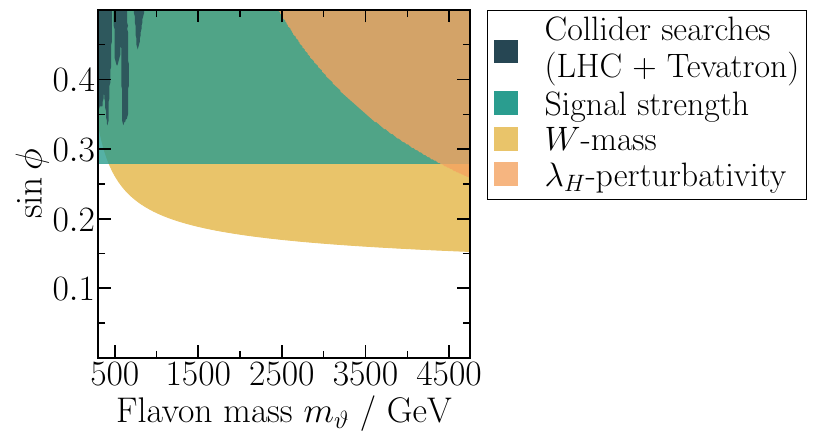
Figure 2. 95% CL limits on the Higgs-flavon mixing angle stemming from direct Higgs searches at the LHC and Tevatron (obtained using HiggsBounds ), ATLAS signal strength measurements, the W boson mass and perturbativity of λ H . The white region is currently allowed. To obtain the M W -bound, we have assumed g Z 0 = 0 . 15 , M Z 0 = 3 TeV, but because M W is only very weakly dependent on the Z 0 parameters, we will use this bound for all values of M Z 0 and g Z 0 considered in this